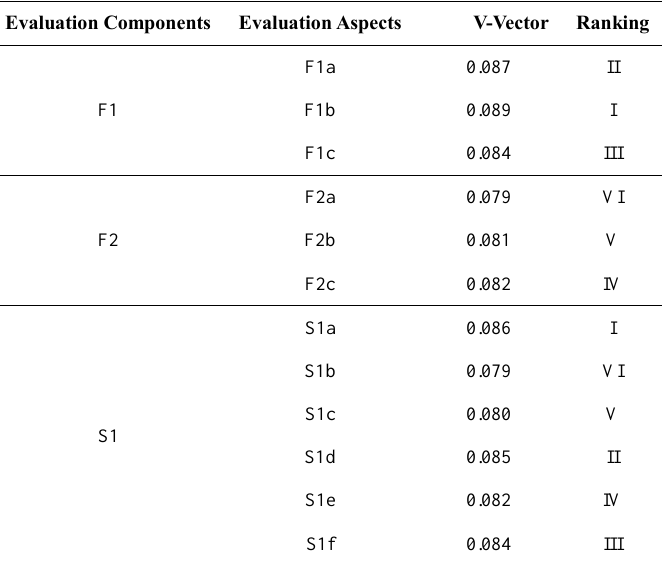
Table 7. Recapitulation of Ranking